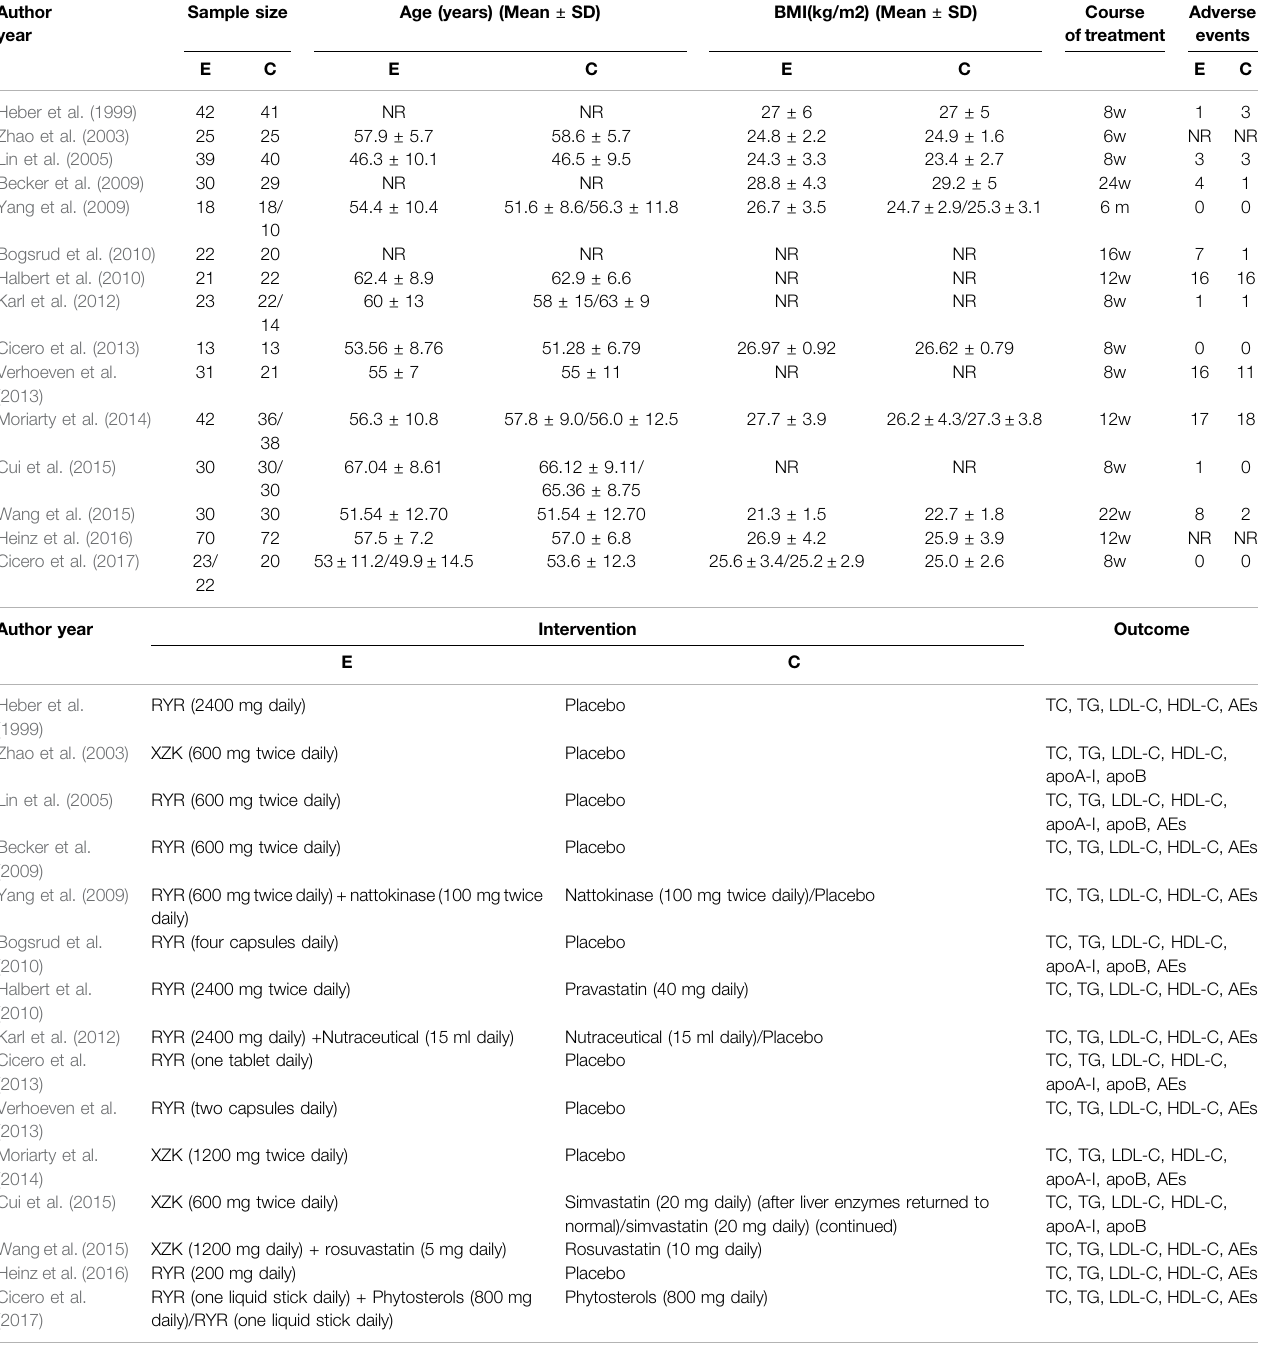
TABLE 1 | Summary of the characteristics of the included